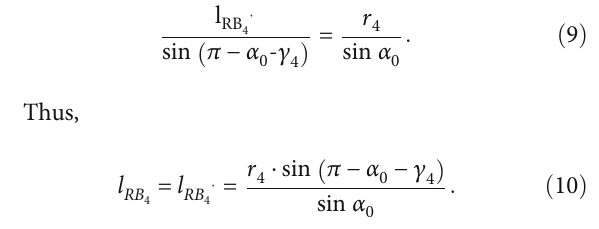
Figure 3. B i ( i = 1, 2, ⋯ , 9 ) is the typical point on the bionic blade curve RB i , the tip of teeth T i is welded and overlap with point B i .